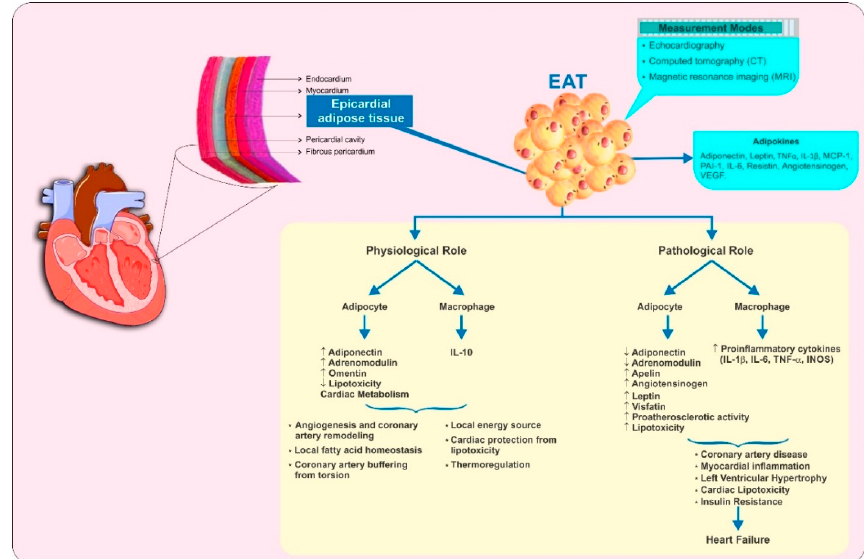
Figure 1. Physiological and pathological functions of epicardial adipose tissue (EAT). Schematic diagram illustrating the anatomical location of EAT, different modalities used to measure it and its various physiological and pathological functions. IL, interleukin; INOS, inducible nitric oxide synthase; MCP-1, monocyte chemoattractant protein-1; PAI-1, plasminogen activator inhibitor-1; TNF- α , tumor necrosis factor α ; VEGF, vascular endothelial growth factor.